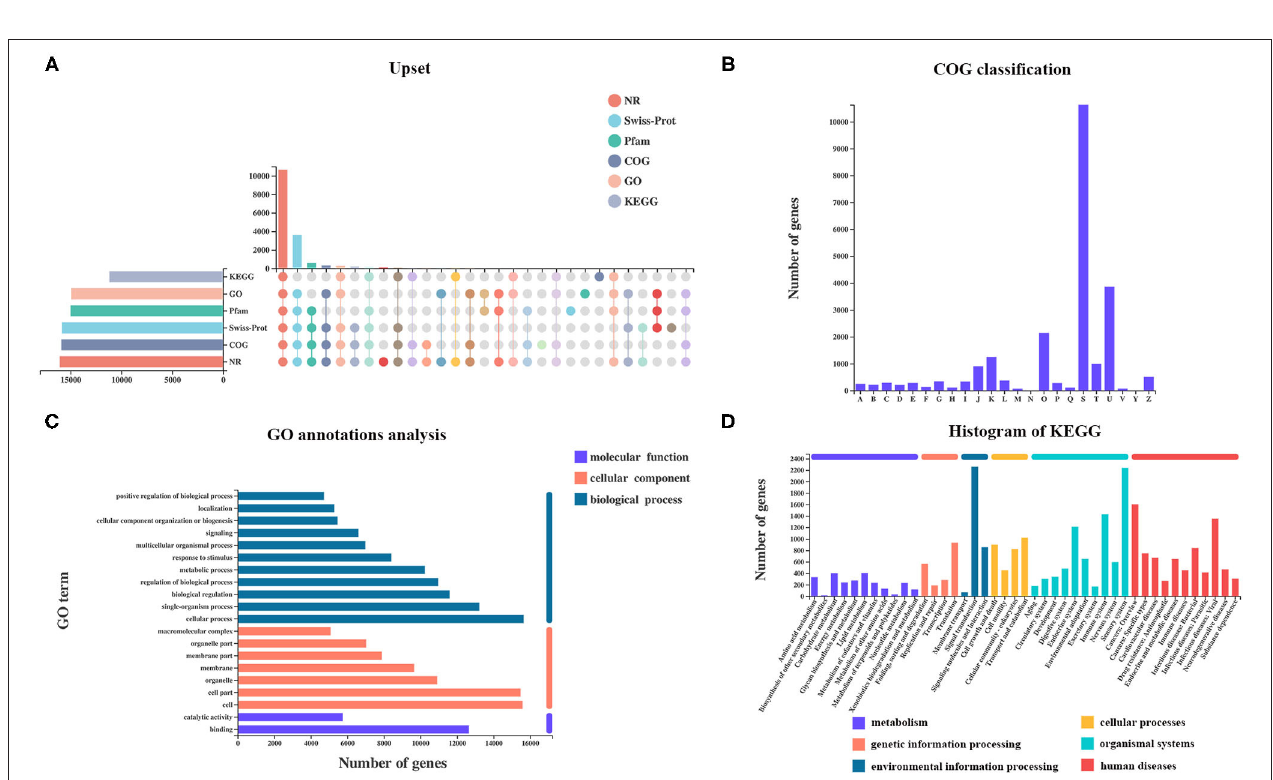
first KEGG categories (metabolism, environmental information